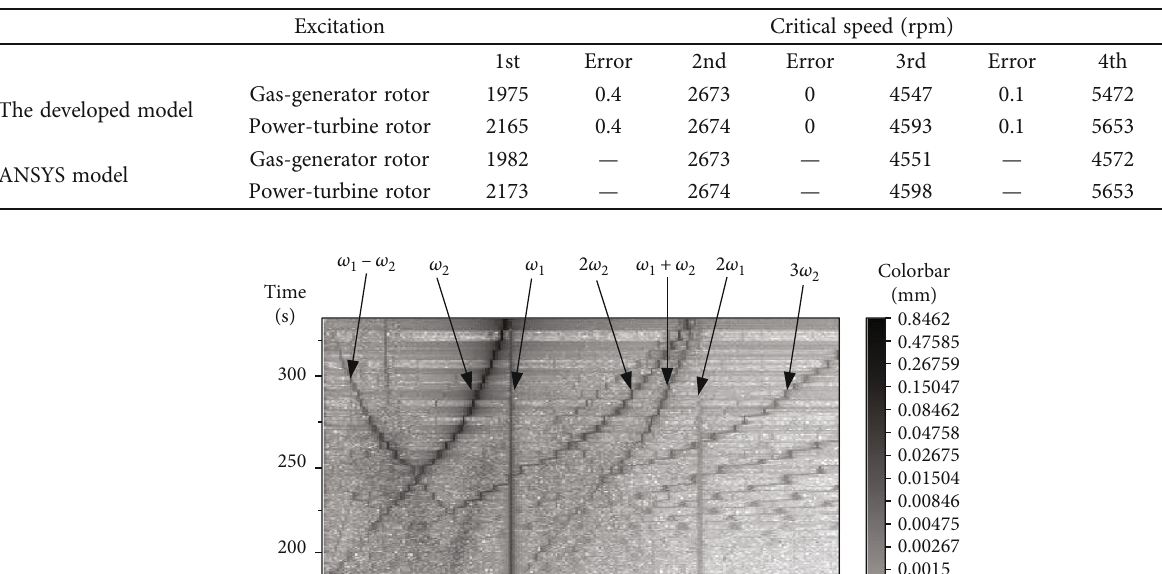
Table 6: Critical speed comparison ( ω = 0 rpm).